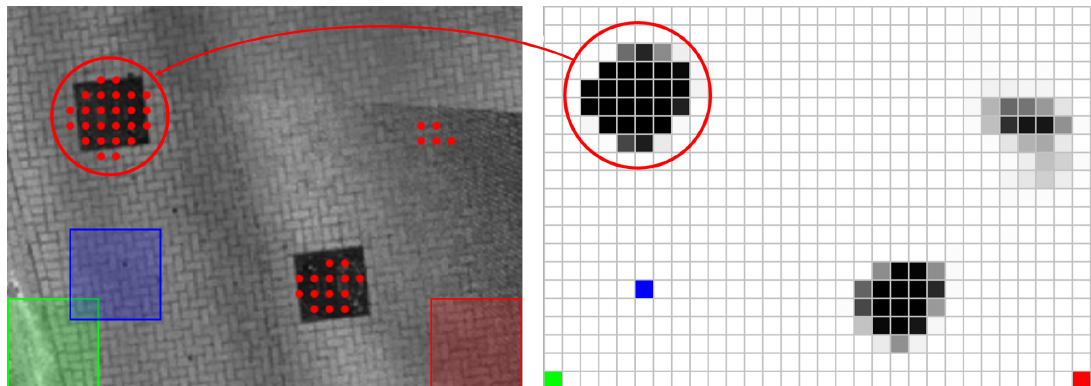
Figure 5. Visualization of the sliding window positions positions of the windows that have a classification score greater than the threshold T class = 0.5 ( left ) and the corresponding clusters in the spatial classification map ( right ). Additionally, the windows of the corresponding highlighted grid cells in red, blue and green from the spatial classification map are shown in the intensity image.